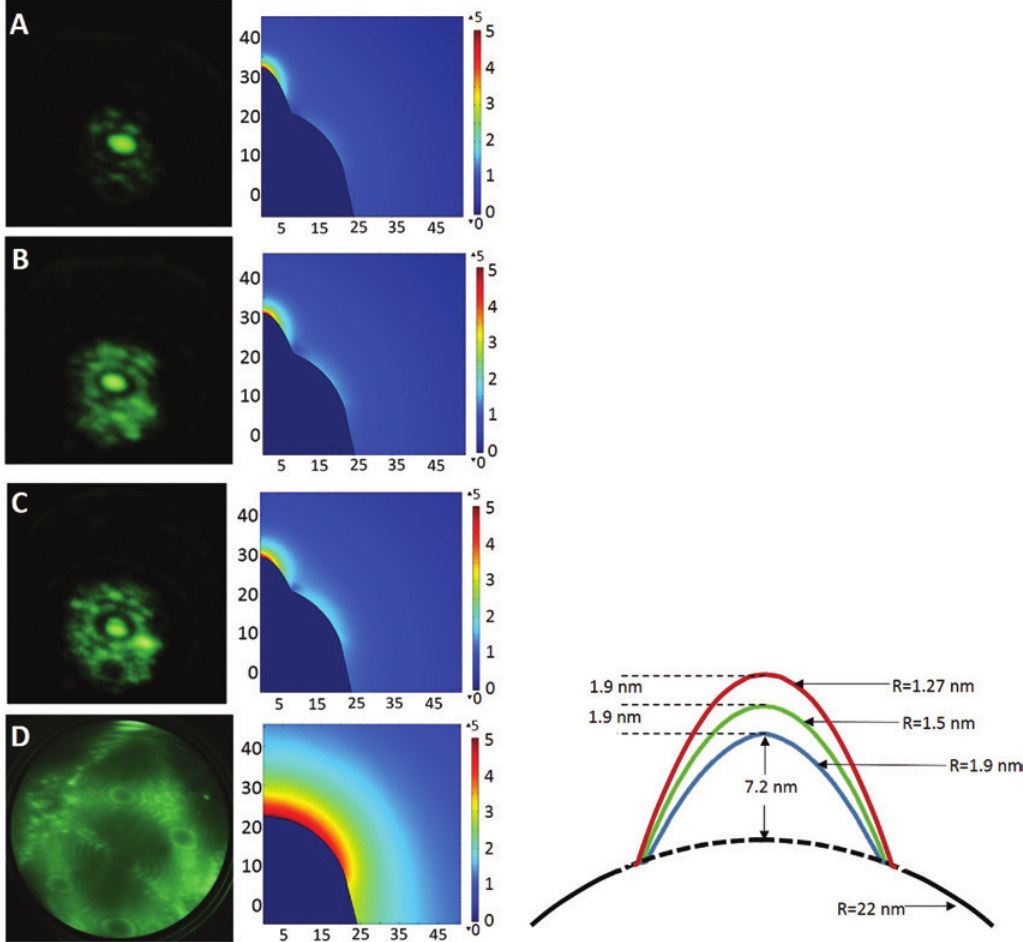
Figure 8: (A–D) FIM image sequence during the nanotip destruction process. An FES model is shown for each FIM